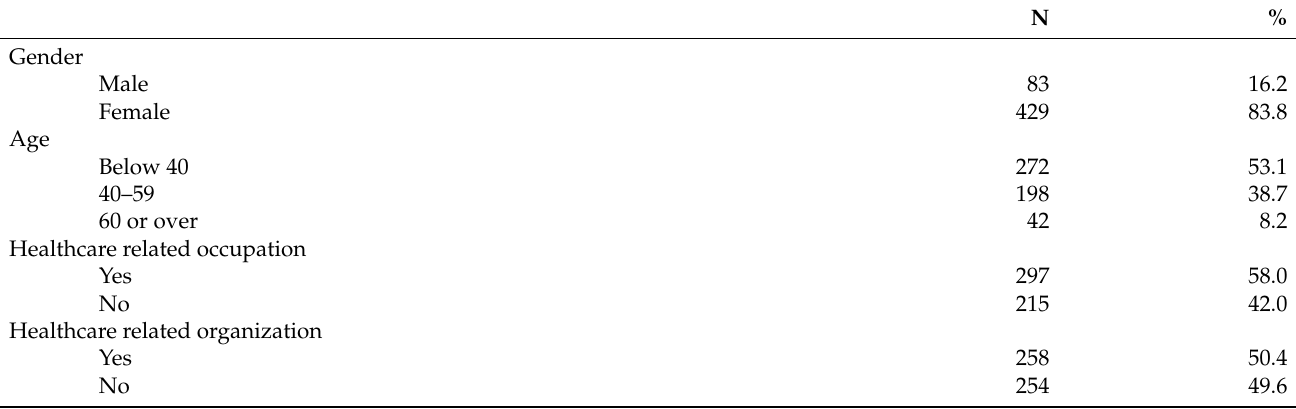
Table 1. Background characteristics of participants (N =